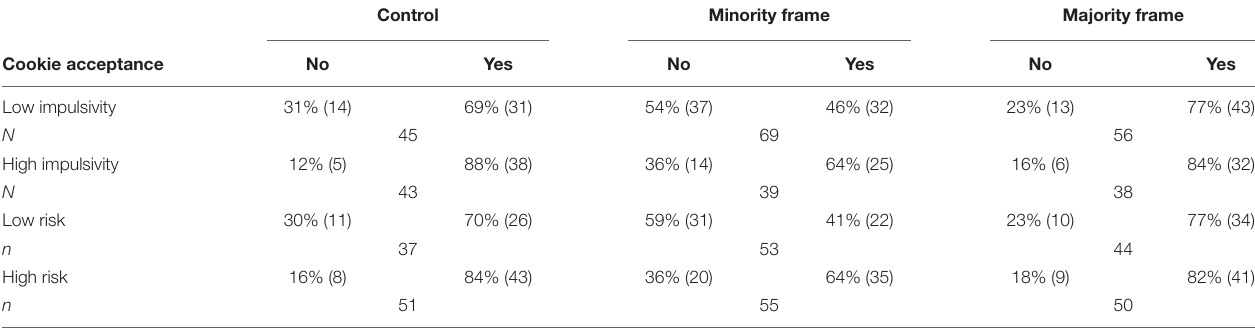
TABLE 3 | Cookie responses based on social group references and impulsive and risk taking grouping.